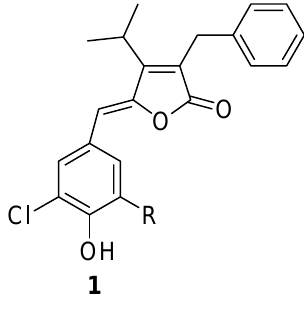
Figure 2 . Structure of the nostoclides (R=Cl, nostoclide I; R=H, nostoclide